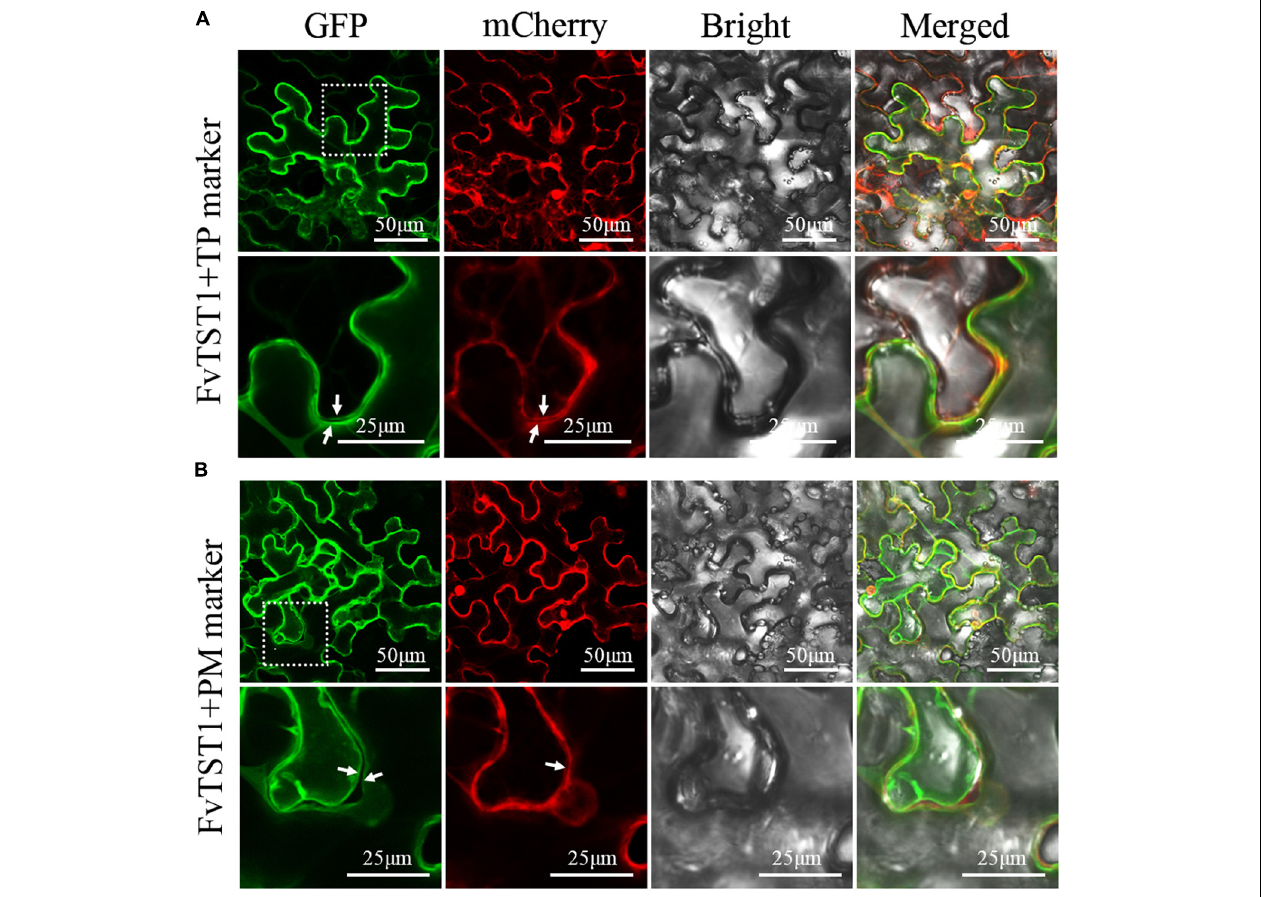
FIGURE 3 | Subcellular localization of FvTST1-GFP fusion protein in Nicotiana benthamiana . (A) Co-localization of FvTST1-GFP with Gamma TIP-mCherry (CD3-975 tonoplast, TP, marker) in N. benthamiana leaves. (B) Co-localization of FvTST1- GFP and PIP2A-mCherry (CD3-1007; plasma membrane, PM, marker) in N. benthamiana leaves. The dashed box indicates the enlarged portion and highlights localization differences between TP and